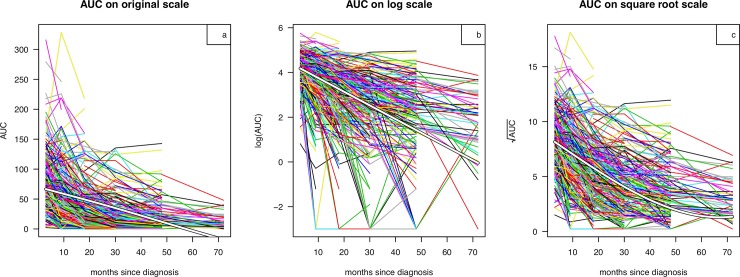
Growth curves of AUC C-peptide versus time since diagnosis in individual patients (coloured lines), with AUC plotted on the (a) original, (b) logarithmic and (c) square root scale. The corresponding mean curves (white) from the fitted SITAR models are shown superimposed.